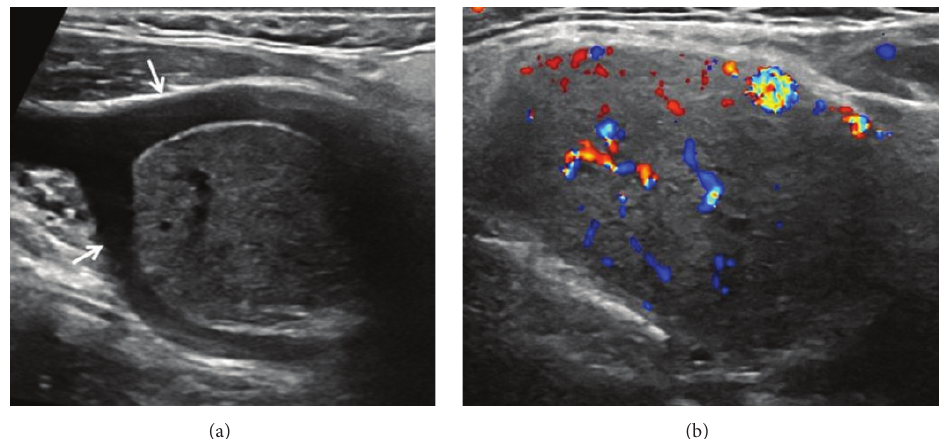
Figure 1: Gray-scale ultrasound (a) shows well defined, solid mass that causes splaying of the internal and external carotid arteries (arrows). High vascularity of lesions is seen in Doppler ultrasound image (b).